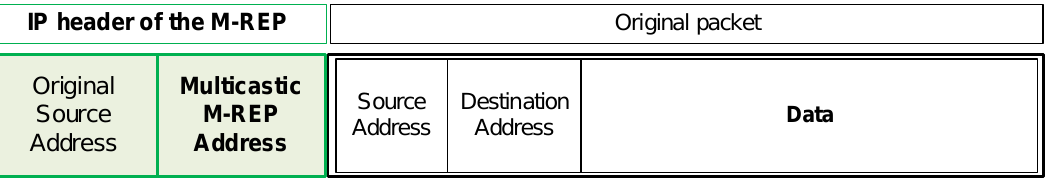
Figure 4. The M-REP encapsulation of the unicast communication.